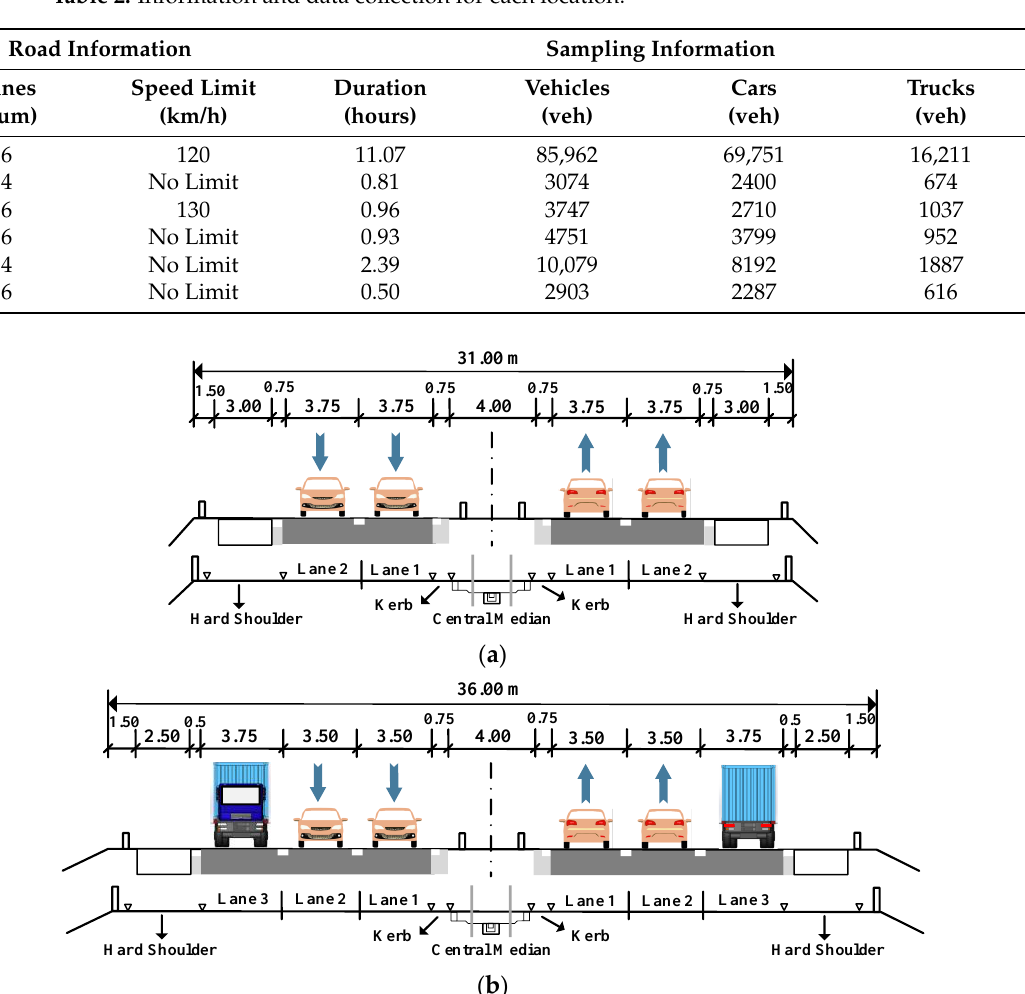
Figure 1. An aerial view of the straight sections on the test freeways. Table 2. Information and data collection for each location. Table 2. Information and data collection for each location.